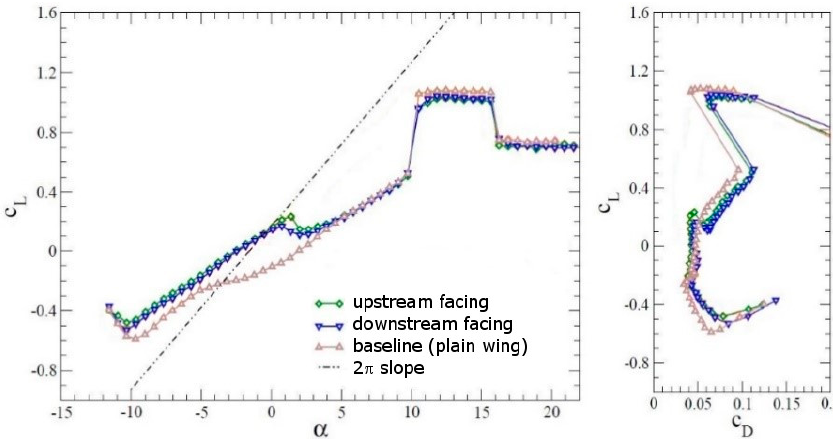
Figure 4. Upstream and downstream facing (deactivated) plasma actuator at 40% chord and plain wing without plasma actuator for Re = 64,200. (Reprinted from [28]).